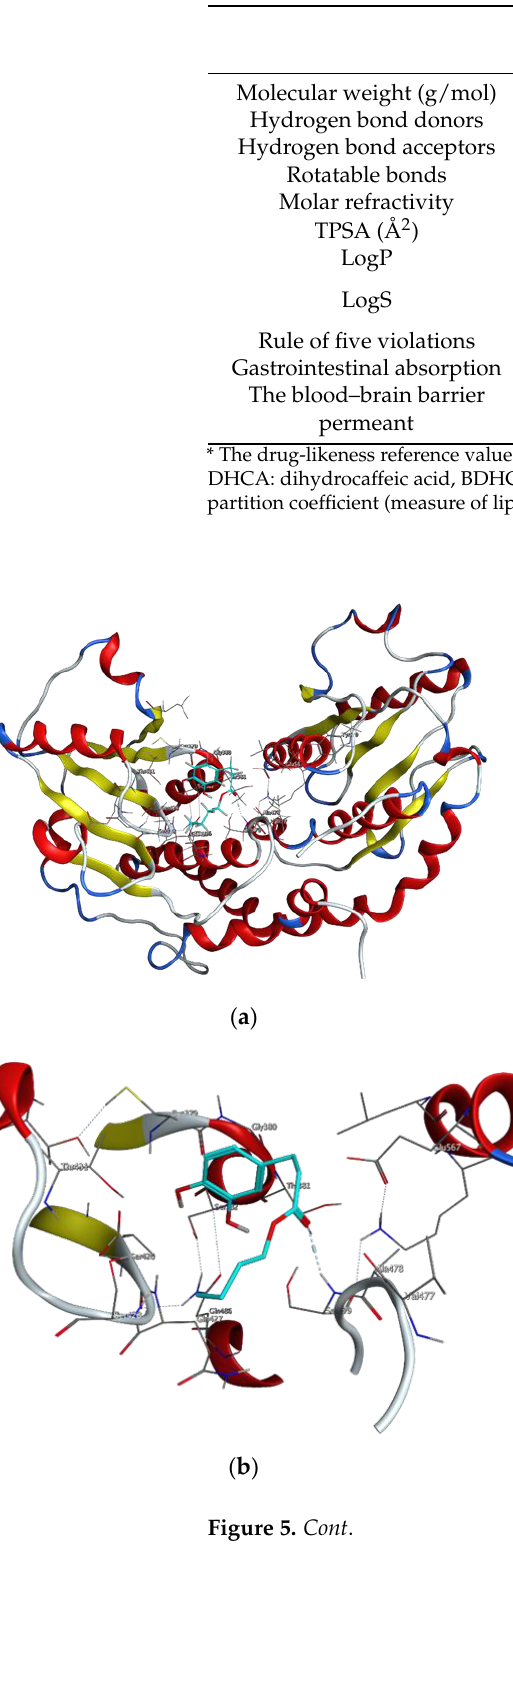
( f ) Figure 5. Visualizations of docking analysis of glutamine-fructose-6-phosphate transaminase (GFAT) binding with butyl dihydrocaffeate: ( a , b ) 3D visualizations, ( c ) 2D binding interactions,